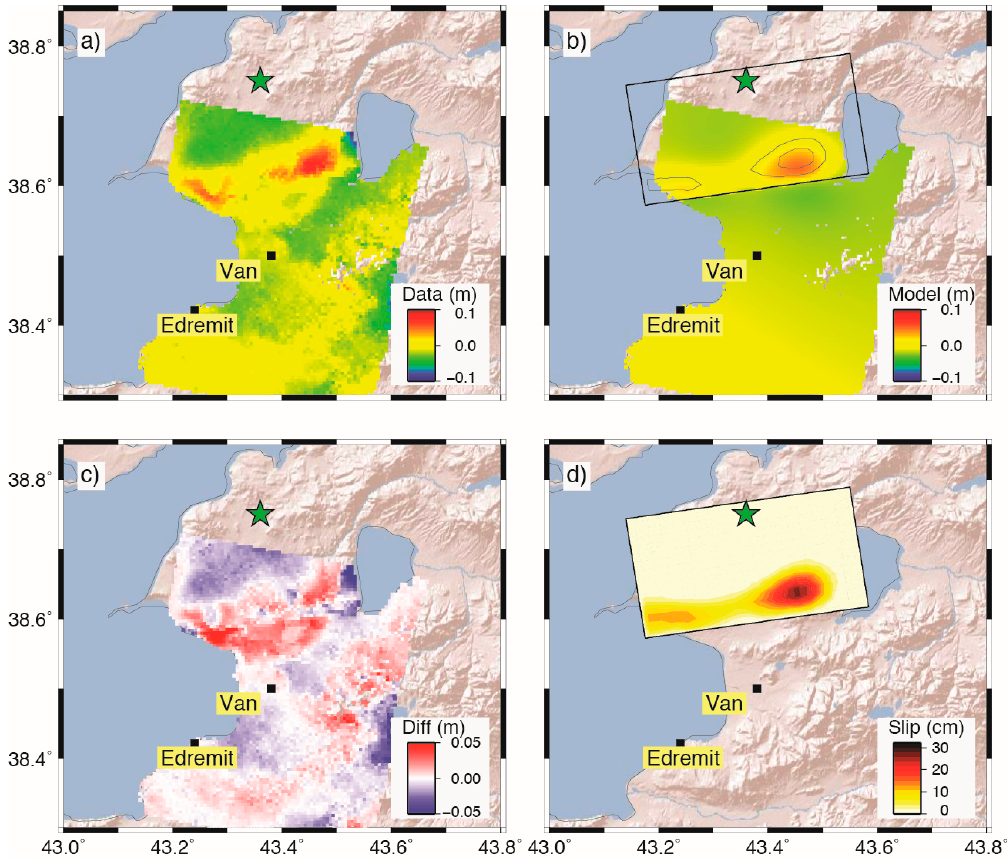
Figure 9. Post-seismic InSAR data and modeling (three-day temporal baseline): ( a ) subsampled CSK2 data (step of 500 m, 5660 data points); ( b ) modeled LOS displacements and the fault afterslip contour each 10 cm; ( c ) residuals (observed minus modeled data); and ( d ) related afterslip distribution. The green star is the mainshock epicenter.